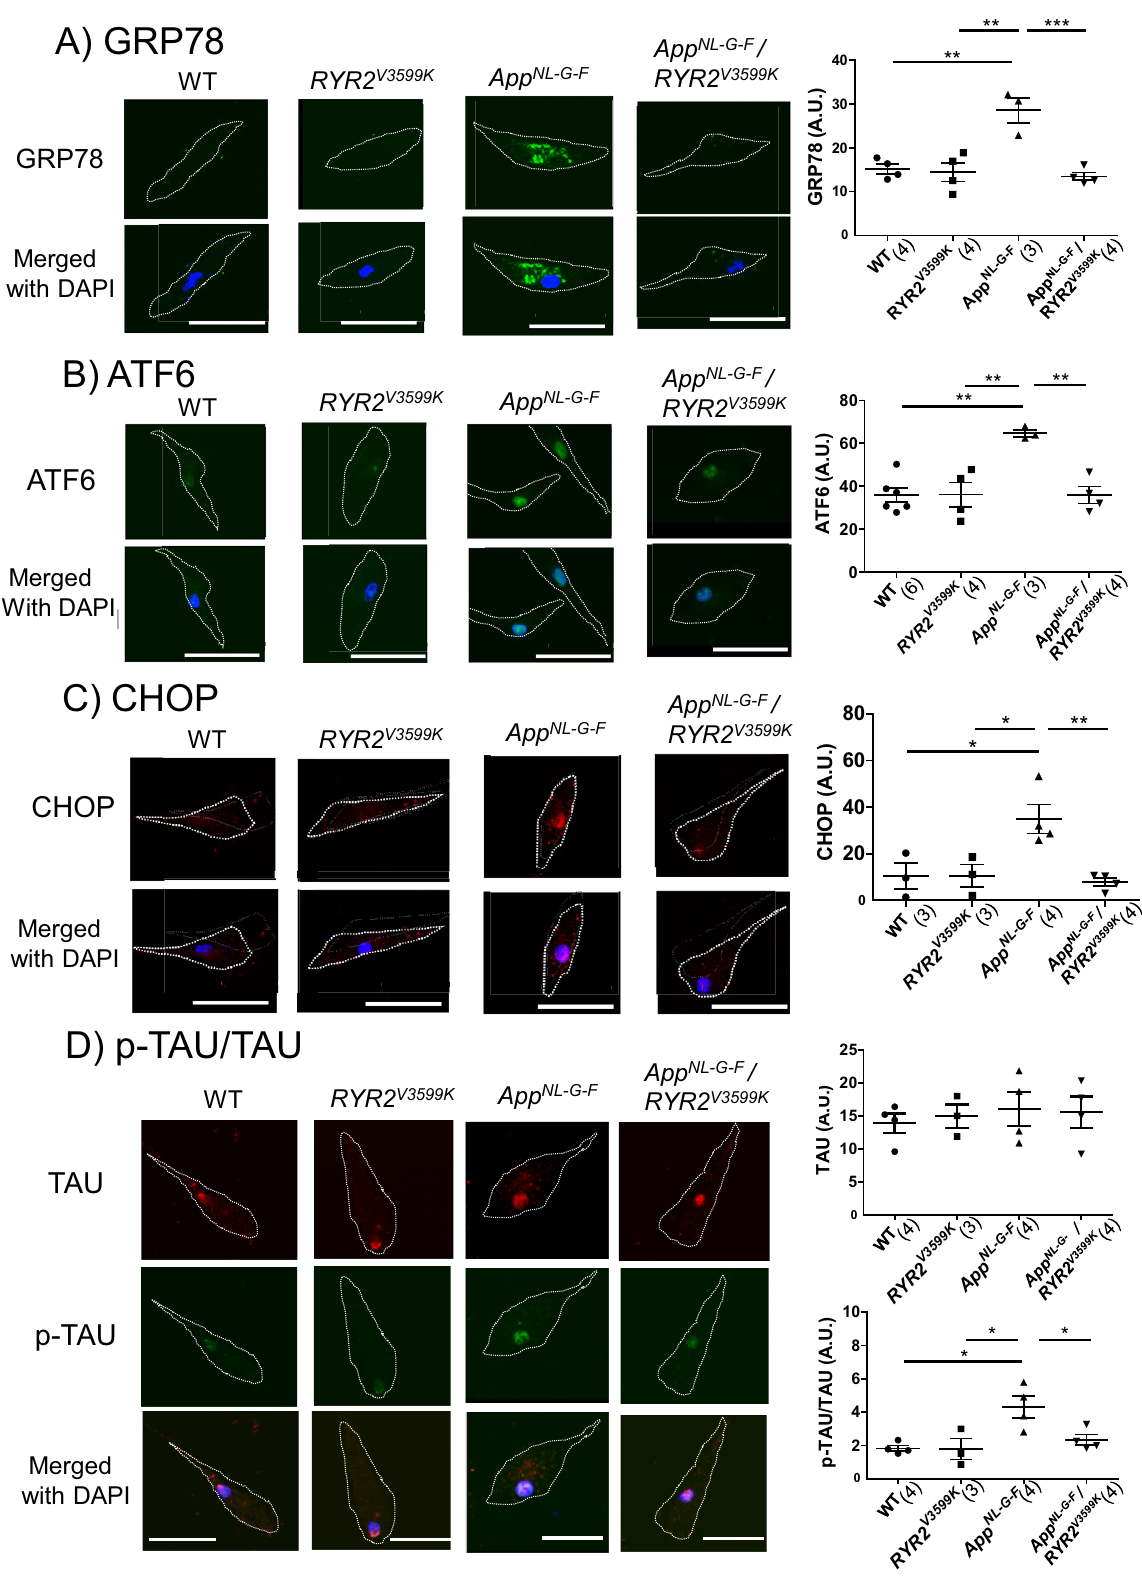
Figure 2. Protein expression of ER stress markers, TAU and p-TAU in WT, App NL-G-F , RYR2 V3599K , and App NL-G-F / RYR2 V3599K incubated neuronal cells. Representative images of ( A ) GRP78, ( B ) ATF6, ( C ) CHOP, ( D ) TAU/p-TAU obtained from single cells, and the summarized data. Merged images with DAPI staining are also shown. p-TAU was expressed as the ratio to total TAU. Cell shapes are indicated by dotted lines. Values for individual mice are plotted together with mean ± SEM. Scale bars: 30 μm. N = 20–33 cells from 3 to 6 mice. Parentheses indicate the number of mice. * p < 0.05, ** p < 0.01, *** p < 0.001 (one-way ANOVA with post-hoc Tukey’s multiple comparison